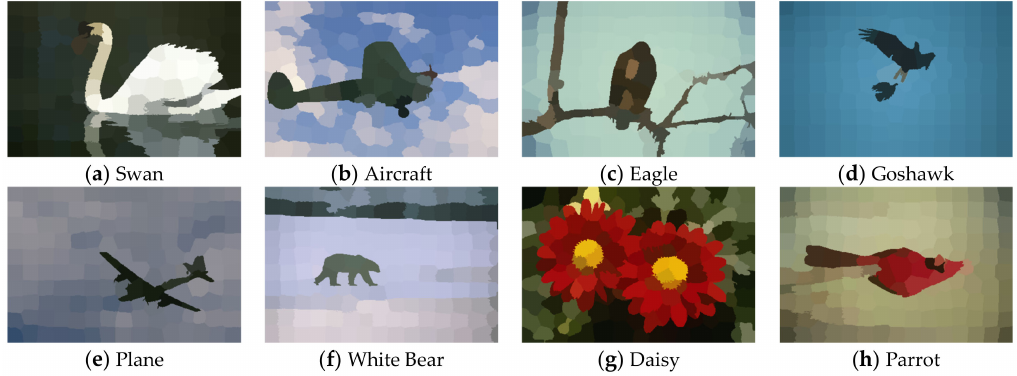
Figure 9. Segmentation results of SLIC approach on eight tested